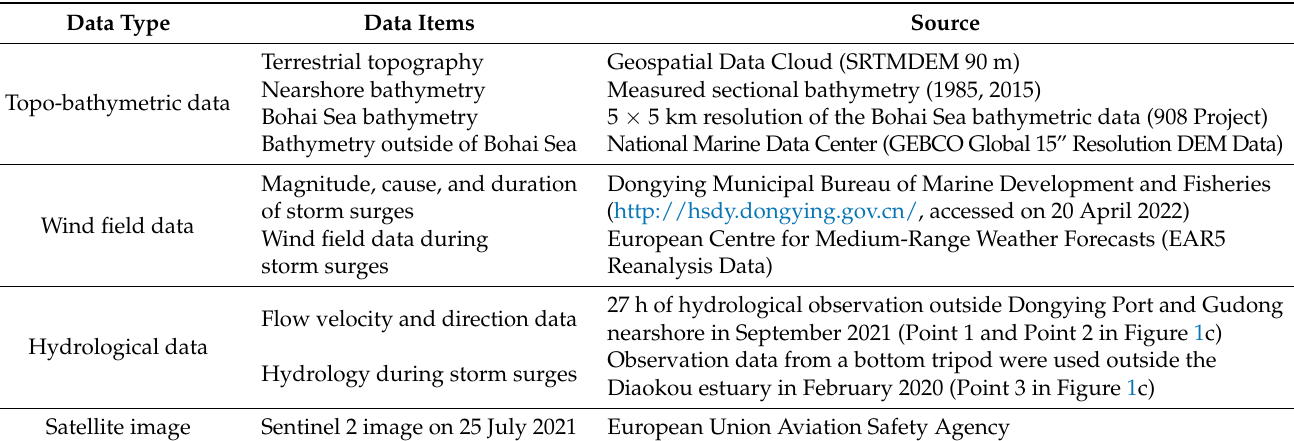
Table 1. Source of included